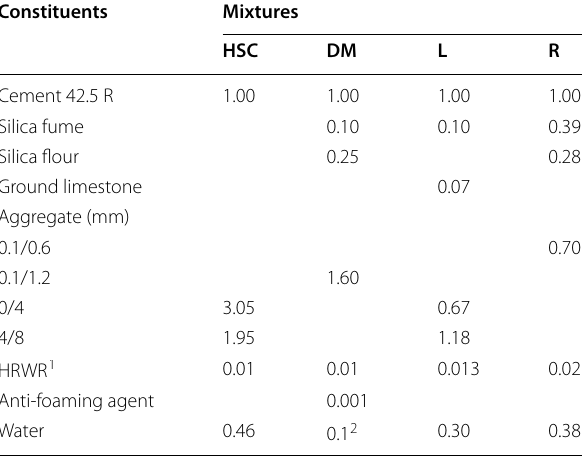
Table 1 Mixtures summary. Adapted after Sovják et al. (2013);